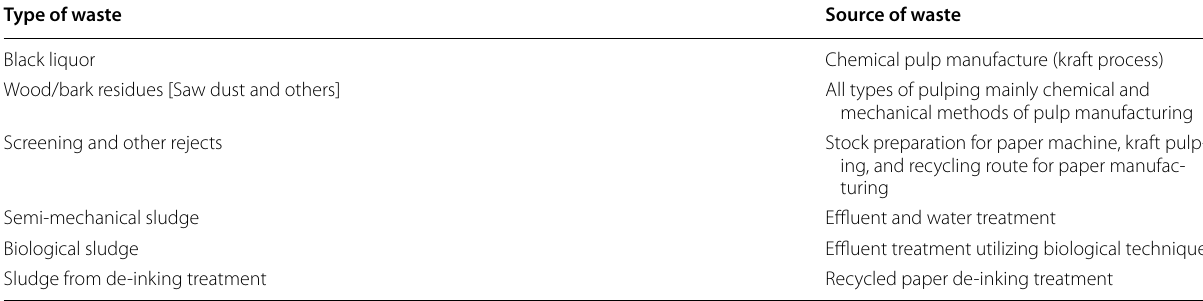
Table 3 Potential pulp and paper mill waste types Type of waste